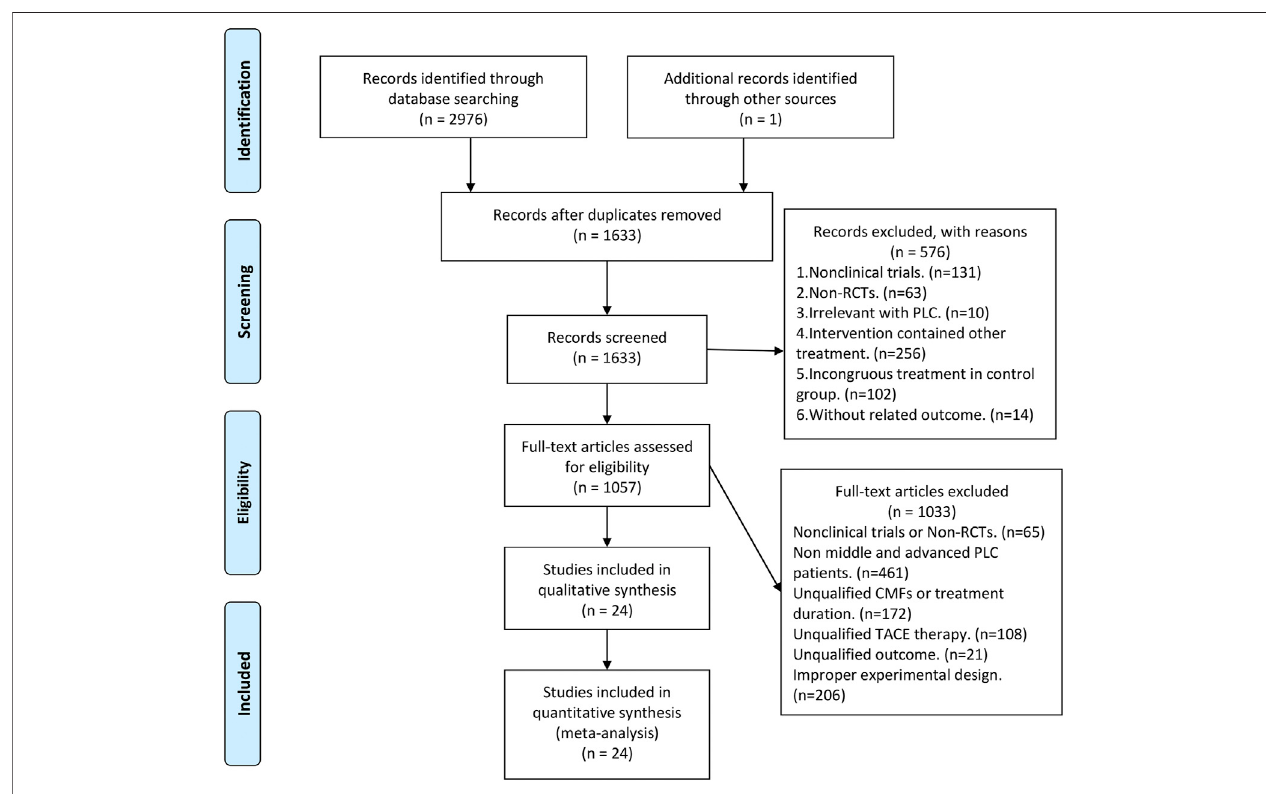
FIGURE 1 | PRISMA fl ow